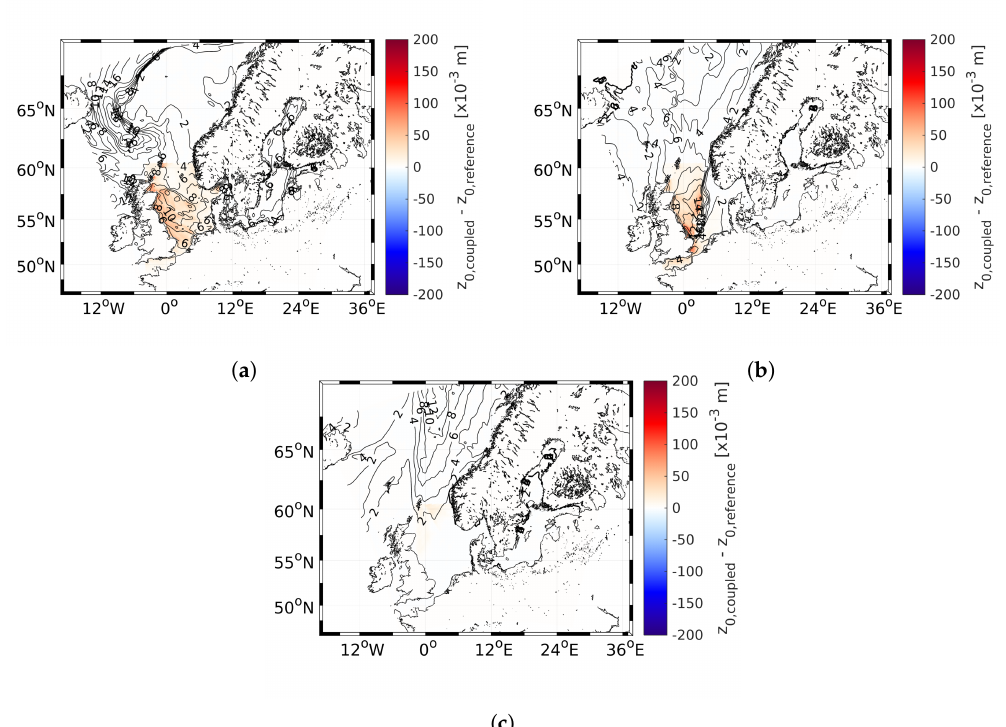
Figure 10. Absolute values of the roughness length in the reference model simulation (contours) and the differences in the roughness length between the coupled and reference model simulations (coloured) on ( a ) 11 January 2017 at 12:00 p.m. UTC; ( b ) 13 January 2017 at 12:00 p.m. UTC; and ( c ) 16 January 2017 at 6:00 a.m. UTC.